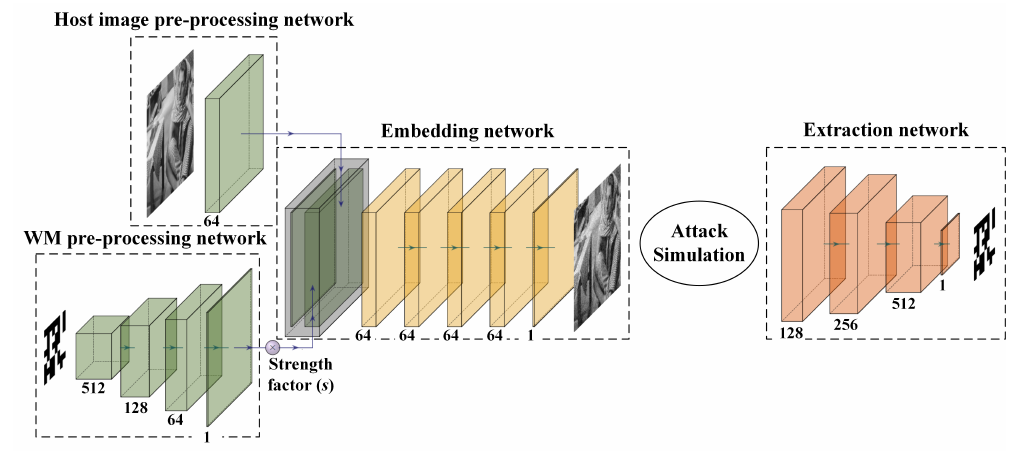
Figure 2. Structure of proposed network for